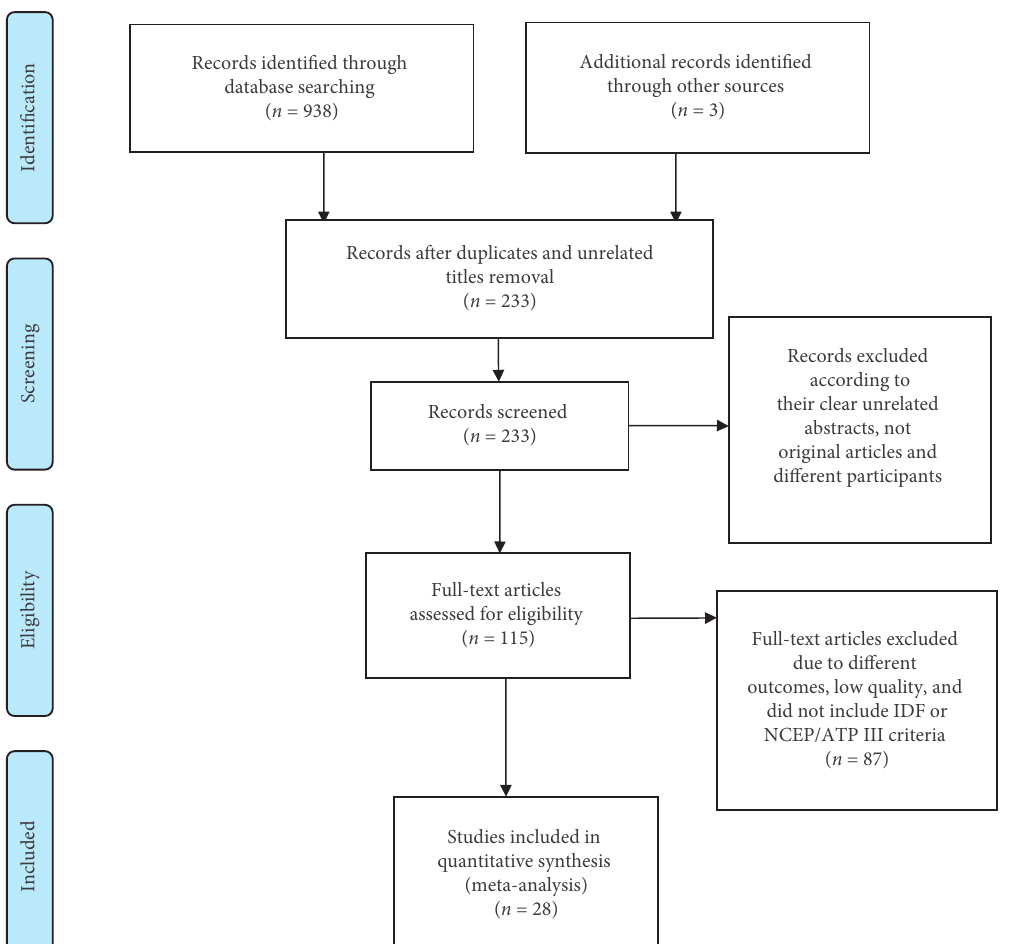
Figure 1: Flow diagram describing the steps of article inclusion to this systematic